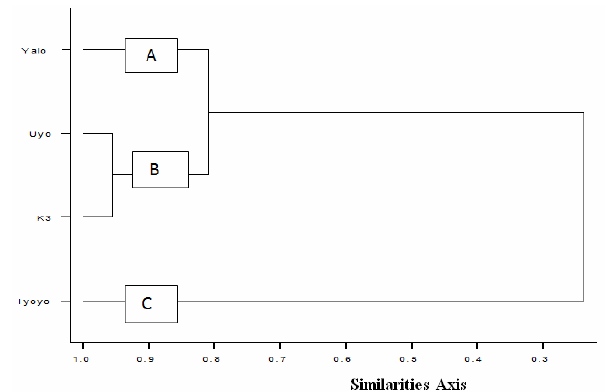
Fig. 1. Dendrogram showing the classification of 4 genitor eggplant genotypes